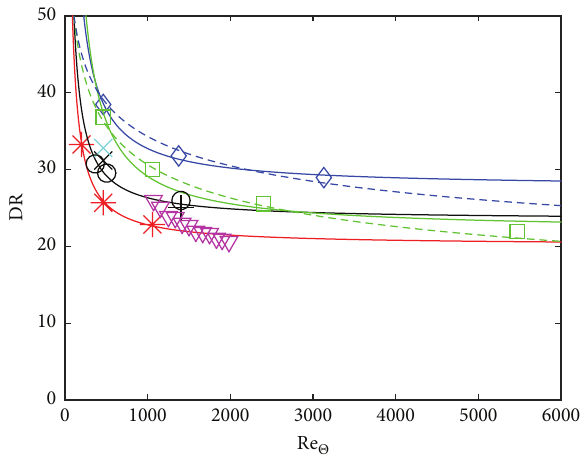
Figure 3: DR as a function of Re Θ . (–) Profiles according to (14). (– –) Profiles according to (15). Black colour indicates data for oscillations with 𝑊 + 𝑚 = 11.3 and 𝑇 + = 67 : ( ⃝ ) DNS from [26], ( × ) for channel flow from [27], and (+) for boundary layer experiments from [28]. Red colour indicates data for oscillations with 𝑊 + 𝑚 = 10 and 𝑇 + = 50 : ( ∗ ) DNS for channel flow from [12]. Green, blue, and cyan colours indicate data for oscillations with 𝑊 + 𝑚 = 12 and 𝑇 + = 100 : ( ⬦ ) DNS for channel flow from [7], ( ◻ ) DNS for channel flow from [9], and ( × ) for channel flow from [27]. Magenta colour indicates data ( 󳶚 ) from the present simulation of a spatially developing boundary layer over oscillations with 𝑊 + 𝑚 = 10.7 and 𝑇 + = 76.4 .